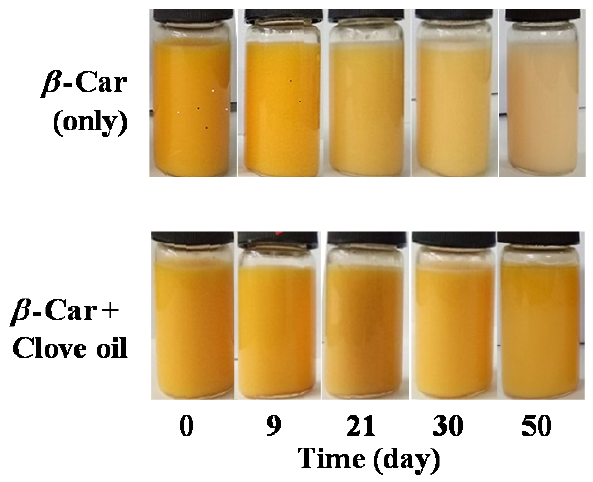
Figure 1. Appearance of oil-in-water with β -Car during storage under ambient conditions and on exposure to light in glass jars with and without addition of 4 µL/mL emulsion of clove oil.